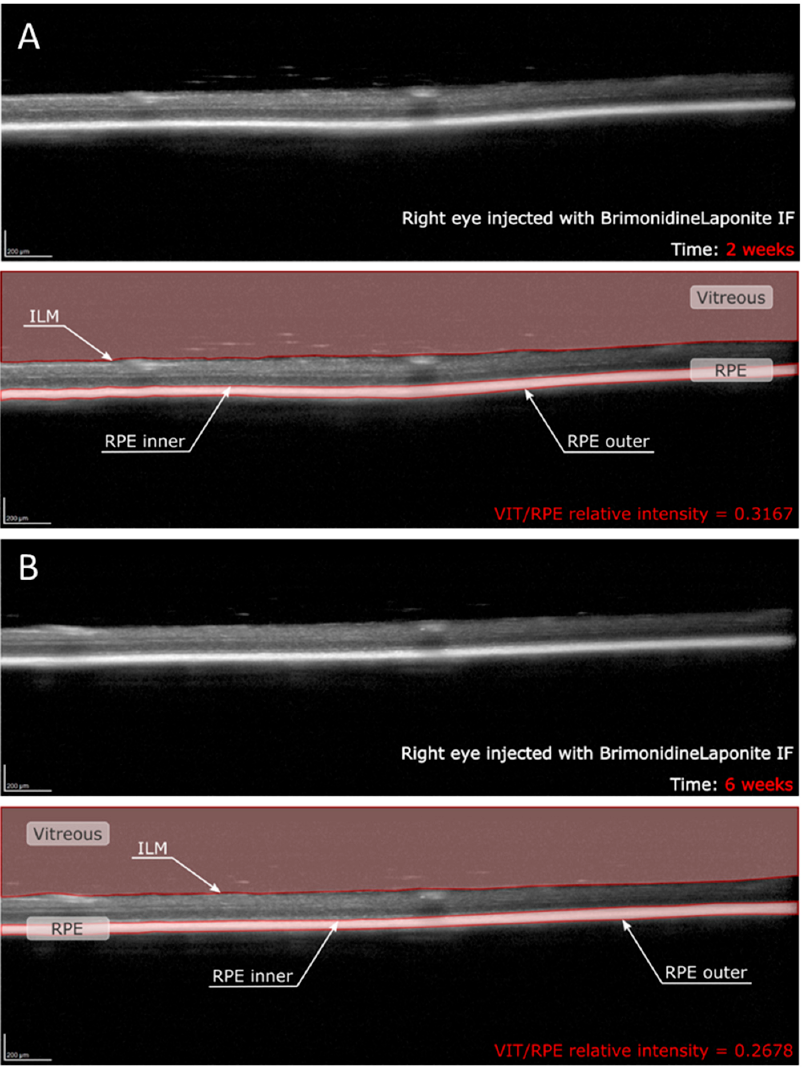
Figure 1. Quantitative assessment of VIT/RPE relative intensity in the same right eye of a rat at ( A ) two weeks and ( B ) six weeks post-injection with brimonidine–Laponite intravitreal formulation. Abbreviations: IF: intravitreal formulation; VIT: vitreous; RPE: retinal pigment epithelium; ILM: inner limiting membrane.